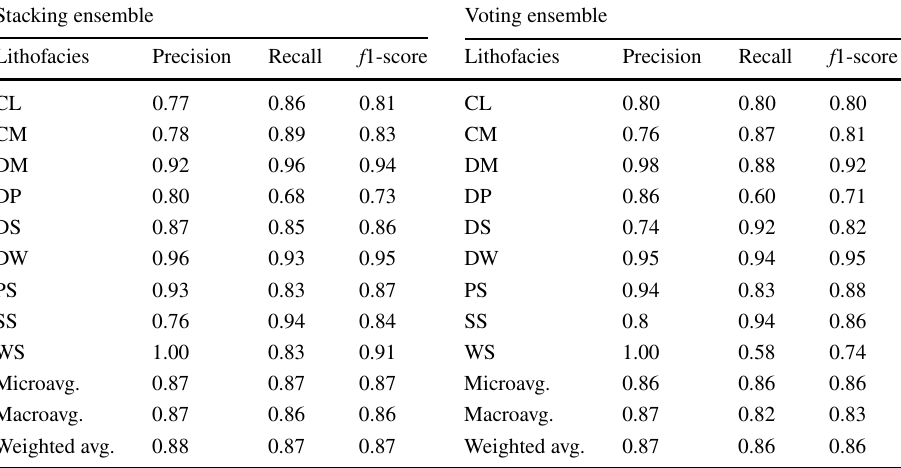
Table 4 The performance of HEMs after tenfold cross- validation for lithofacies